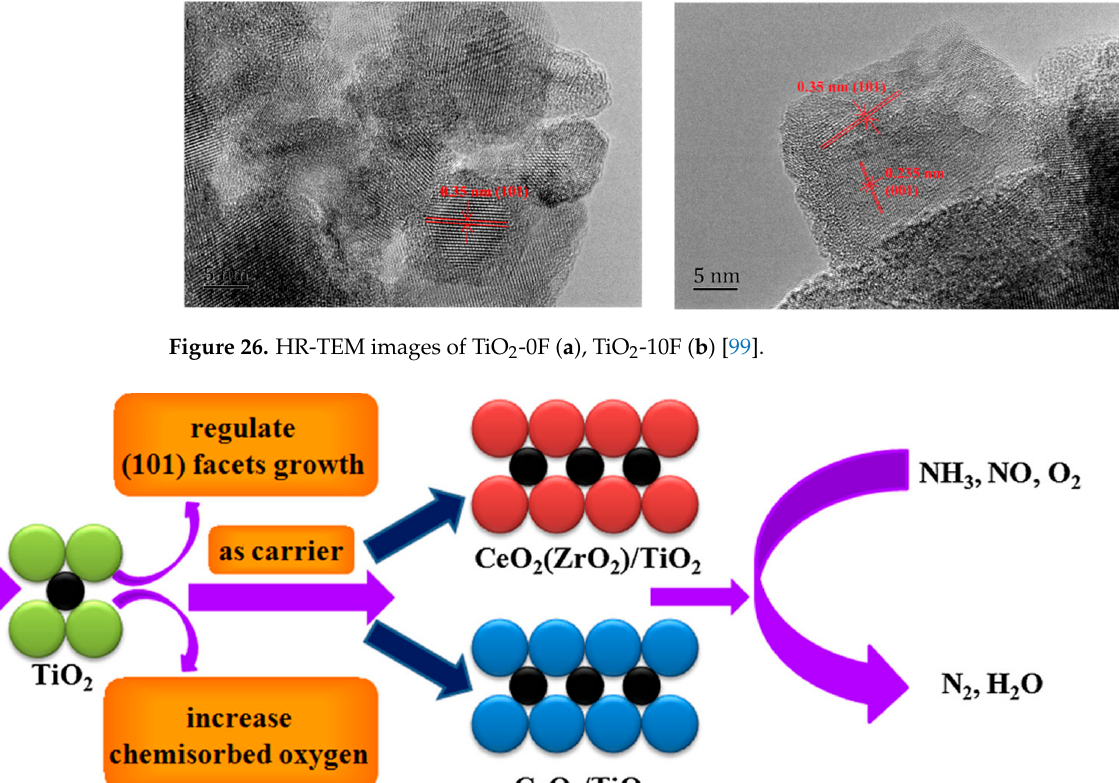
Figure 27. Influence mechanism of HF on CeO 2 (ZrO 2 )/TiO 2 catalysts [99].